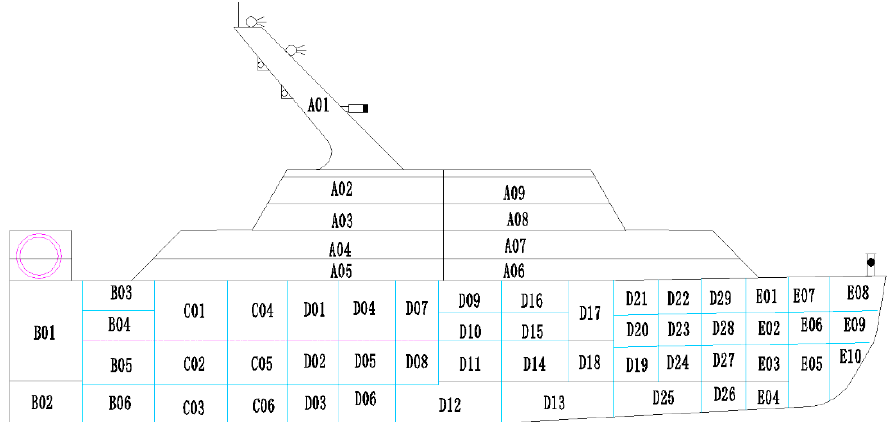
Figure 4. Schematic diagram of patrol boat section subdivision.